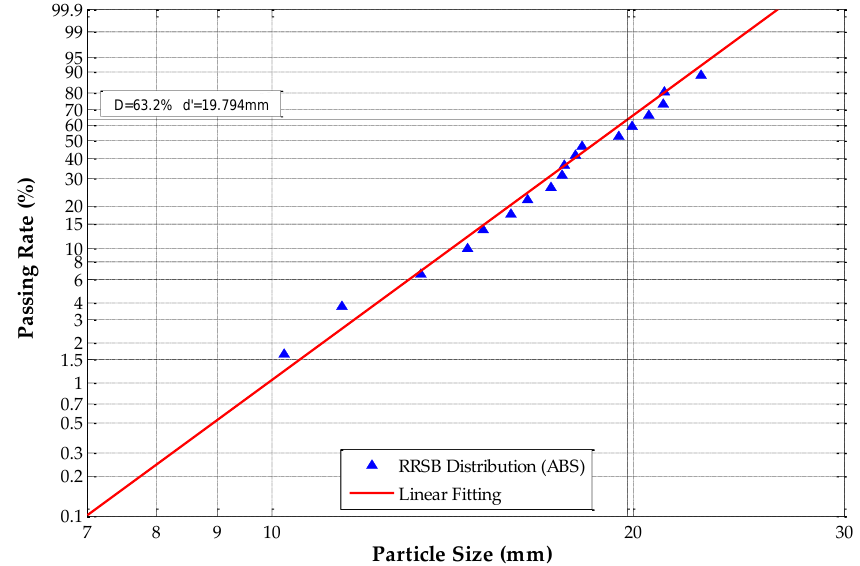
Figure 8. Rosin–Rammler–Sperling–Bennet (RRSB) distribution of acrylonitrile-butadiene-styrene (ABS) scraps.